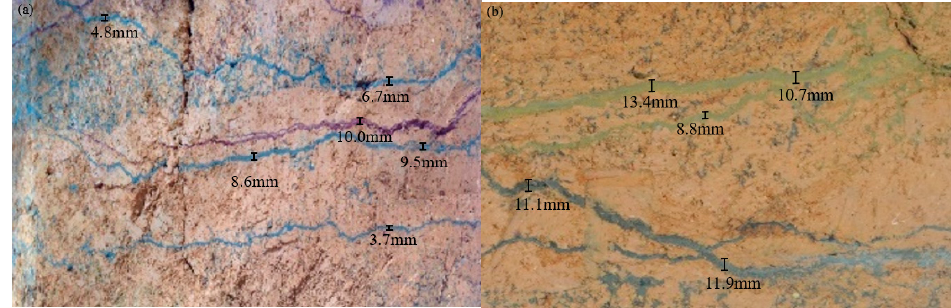
Figure 10. Parallel dispersed grouting veins: ( a ) original ‐ red parallel dispersed grouting veins and ( b ) blue ‐ yellow parallel dispersed grouting veins.